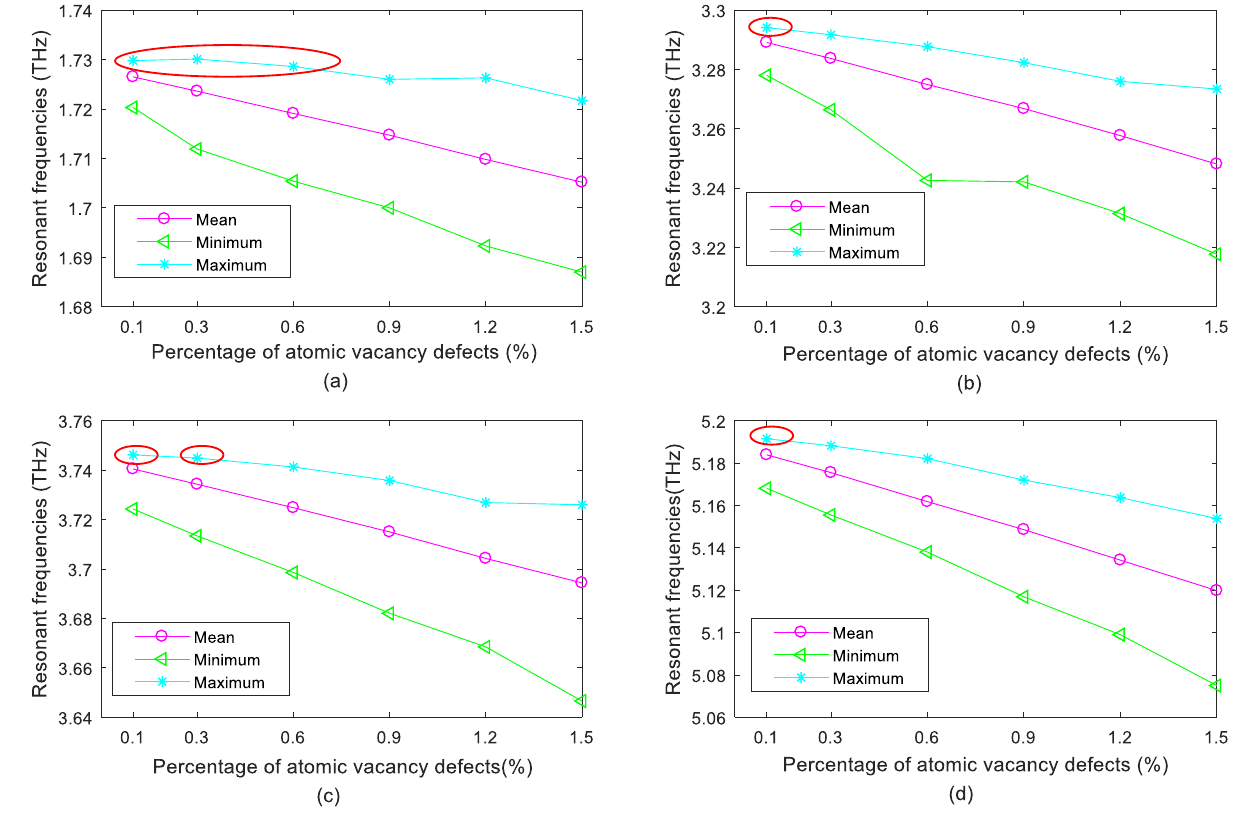
Figure 1. Statistical results of resonant frequencies for porous graphene (( a – d ) are for the first- to fourth-order vibration modes, respectively; the red ellipses mark the points that larger than the corresponding value of the initial grapehene) .